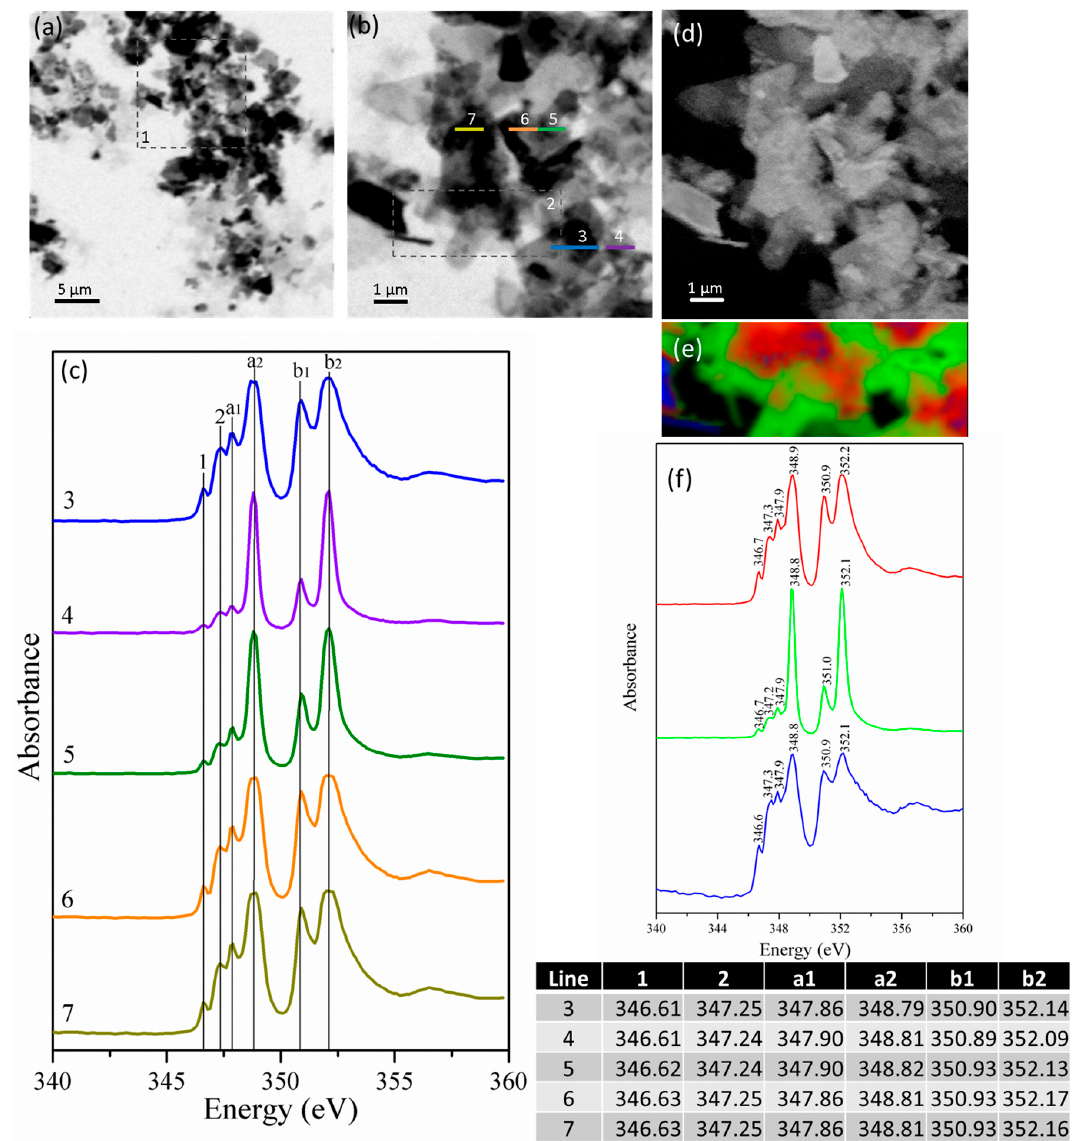
Figure 8. ( a ) Image taken at the calcium L II,III edge of the mix of the orthorhombic C 3 A and gypsum sample at a ratio of 0.2; ( b ) magnification of area 1 in ( a ); ( c ) NEXAFS spectra of the line scans 3–7 indicated in ( b ); ( d ) image maps of calcium in the same area as ( b ), where the brighter areas are related to higher concentration of calcium; ( e ) RGB composite map of region 2 in Figure 8b; and ( f ) NEXAFS spectra of the red, green and blue regions observed in ( e ).